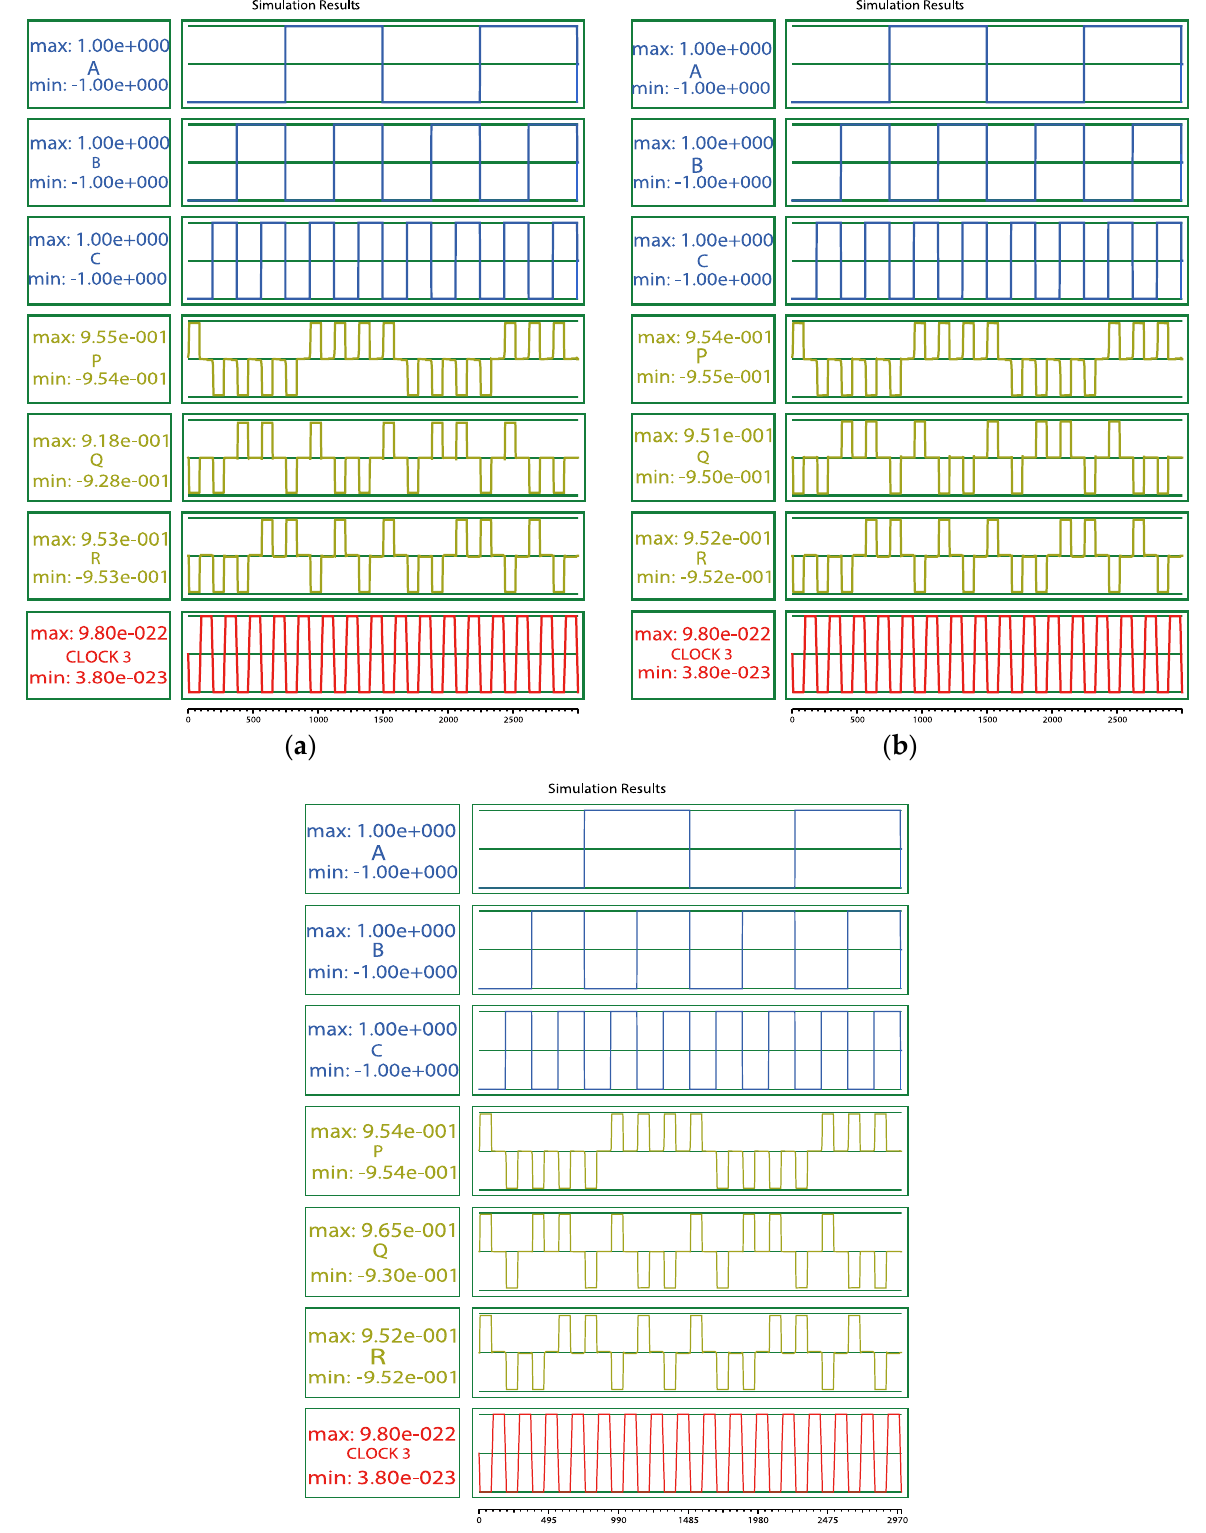
Figure 18. Simulation results of the proposed reversible gates. ( a ) The first reversible gate (RG1), ( b ) the second reversible gate (RG2), and ( c ) the third reversible gate implemented by using the XOR in [5] (RG3).